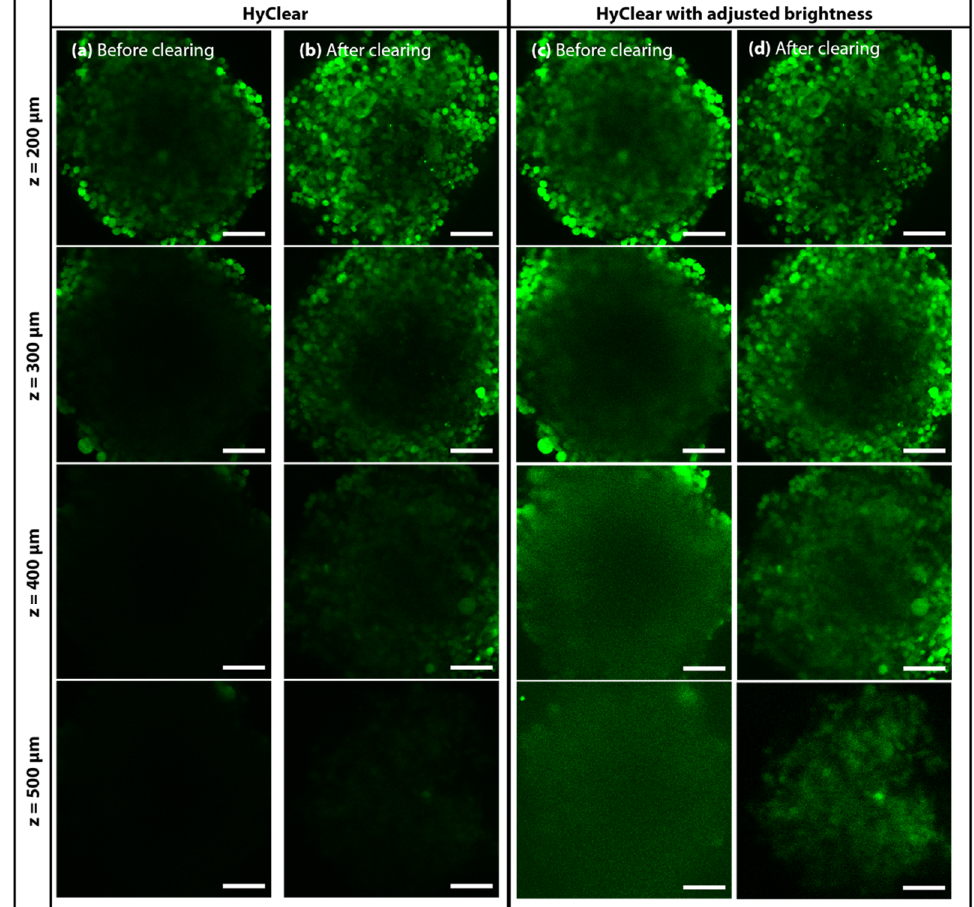
Figure 8. Two ‐ photon microscopy image slices of a tumour spheroid at 200, 300, 400 and 500 μ m deep into the tissue ( a ) before HyClear with 6.4 M Urea clearing with the corresponding z ‐ stacks and ( b ) after clearing. The 3 ‐ D projection image of the spheroids is shown on the bottom. ( c , d ) are the histogram adjusted version of ( a , b ) at each depth, respectively. The scale bars represent 100 μ m. The images were obtained using an Olympus FV1000 MPE microscope with a 25× water dipping objective.